Question: In a single sentence, describe what this figure presents.
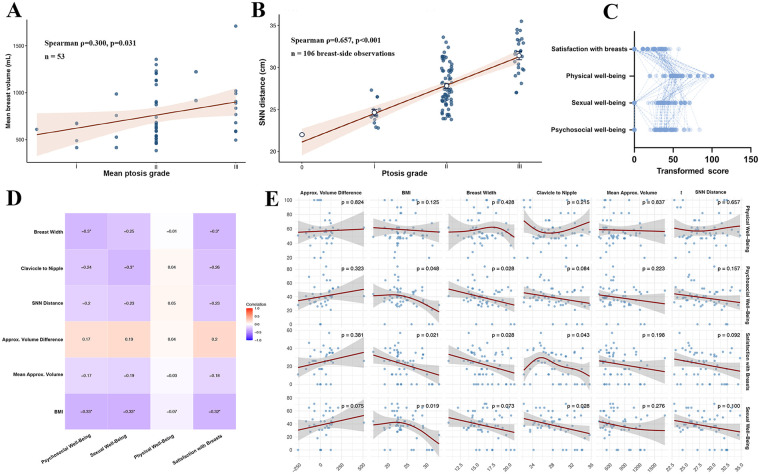
Answer: Correlation between breast morphology and BREAST-Q scales in 53 patients. (A) Association between mean ptosis grade and mean breast volume, shown with a linear regression line and 95% confidence interval; (B) Association between ptosis grade and SNN distance, shown with a linear regression line and 95% confidence interval; (C) Distribution of transformed BREAST-Q scores across the four domains; (D) Correlation matrix illustrating relationships among breast measurements, BMI and BREAST-Q domains; (E) GAMs demonstrating nonlinear associations between breast measurements and transformed BREAST-Q scores. SNN, Sternal notch-to-nipple; BMI, body mass index; GAMs, Generalized additive models; Statistical significance: * P < 0.05, ** P < 0.01, *** P < 0.001.